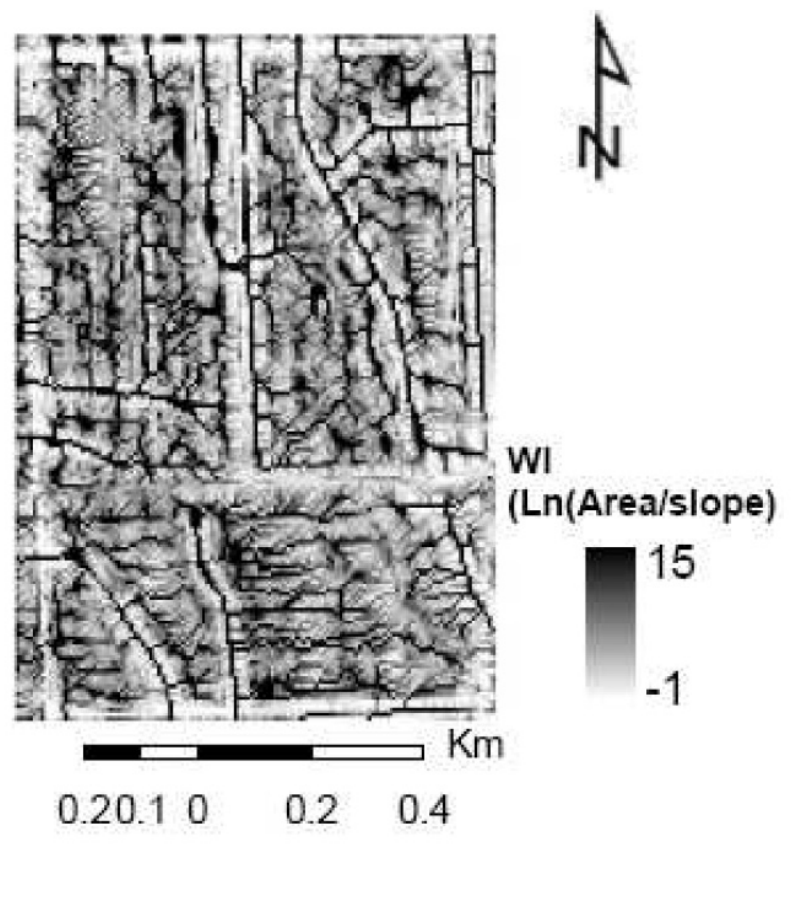
Figure 8. Wetness index of a wheat field in North Dakota as mapped from microtopography